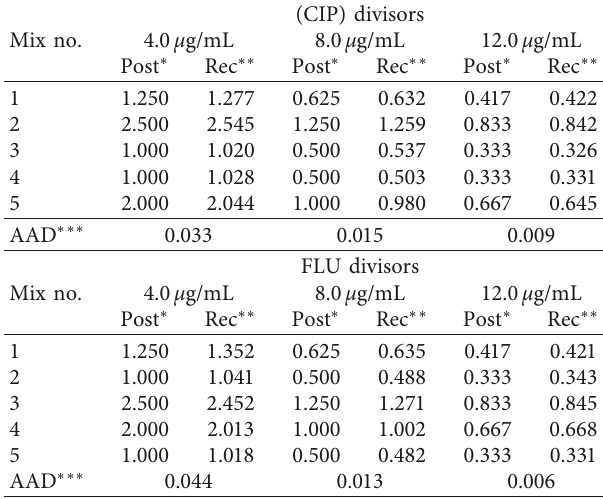
Figure 3: Zero-order spectra of (a) (CIP) (12.0 μ g/mL) and (b) FLU (1.0 μ g/mL) showing the ratio of the dosage form. Table 1: Selection of the best divisor of (CIP) and FLU by the optimization